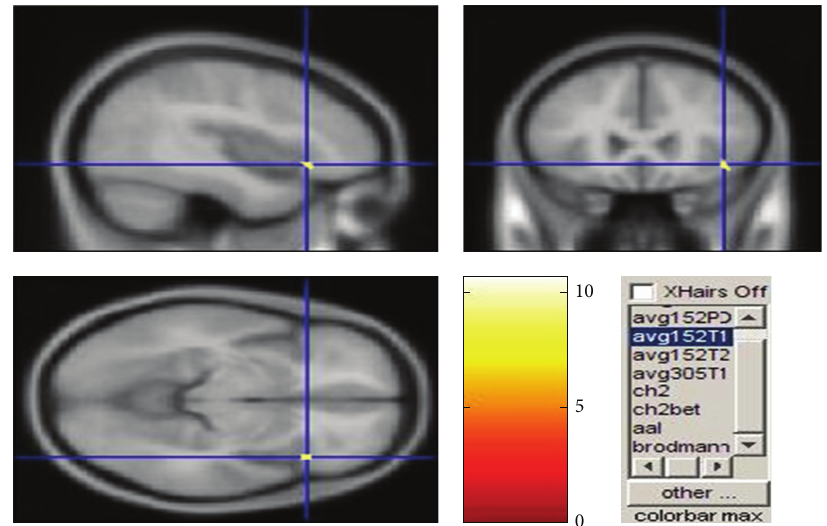
Figure 4: Plane graph of activity region inside